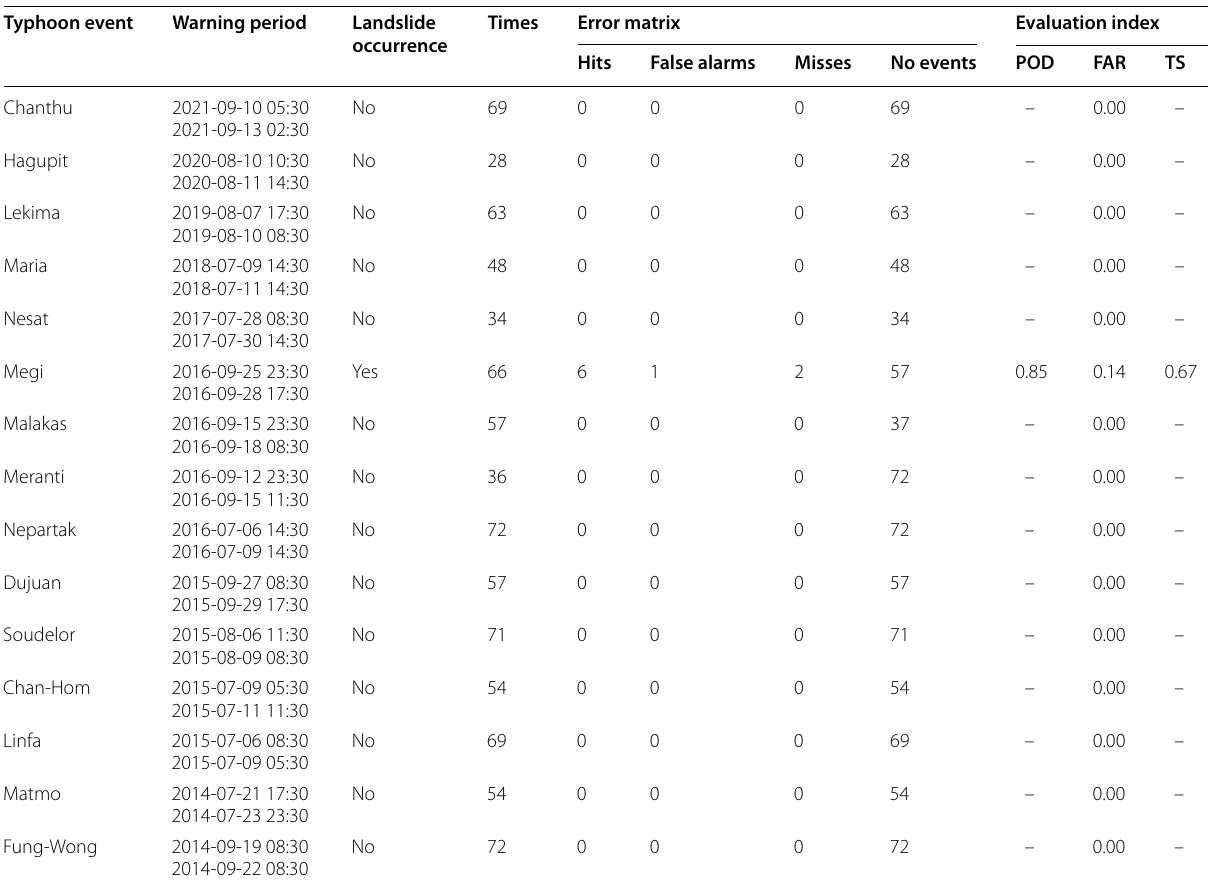
“–” denotes unavailability of POD and TS because the typhoon did not cause any landslides